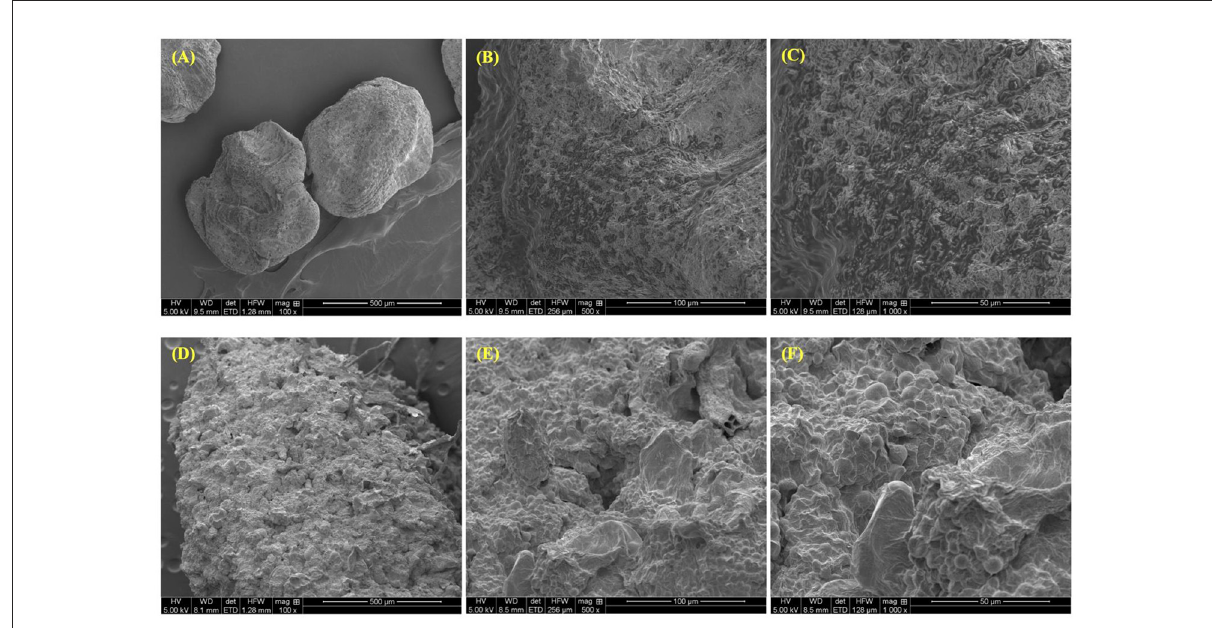
FIGURE6 Scanning electron microscope images showing pawpaw pulp close to the seeds (A–C) and pawpaw pulp further from the seeds (D–F) at magnifications of 100x, 500x, and